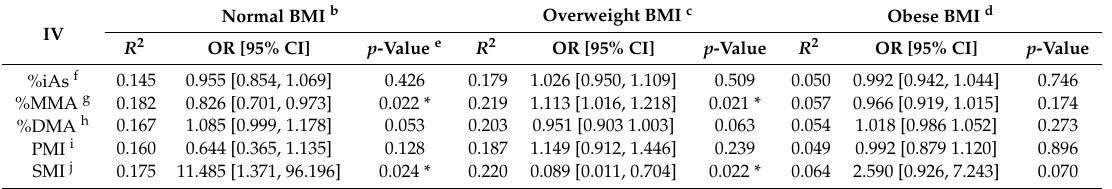
Table 6. Binary logistic regression; DV: Metabolic syndrome in women, fully adjusted model a . Normal BMI b Overweight BMI c Obese BMI IV